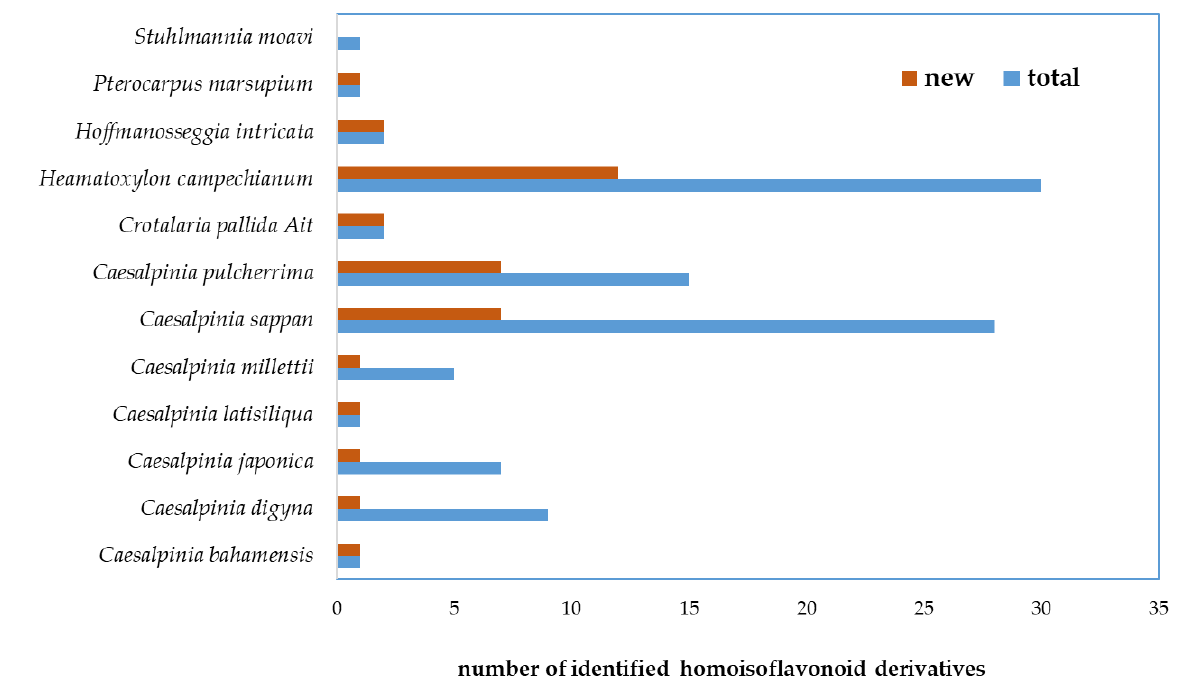
Figure 3. Abundance comparison of the novel homoisoflavonoids (identified for the first time) with total derivatives isolated from species of Fabaceae family.